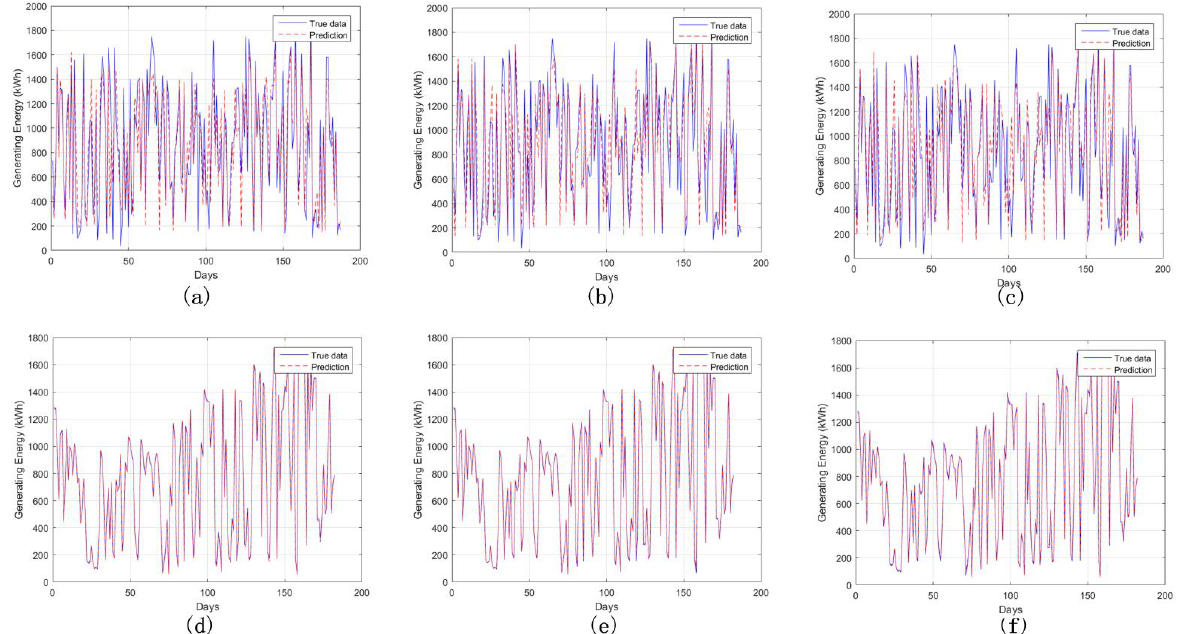
Figure 6. Prediction results of different algorithms. ( a ) PGPM based on SVR; ( b ) PGPM based on Decision Tree; ( c ) PGPM based on Random Forest; ( d ) PGPM based on LSTM; ( e ) PGPM based on Bi-LSTM; ( f ) Ours.